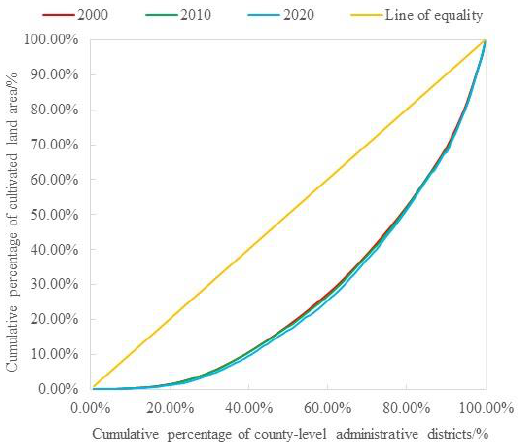
Figure 3. Lorenz curves of spatial distribution of cultivated land resources in Guangdong Province in 2000, 2010, and